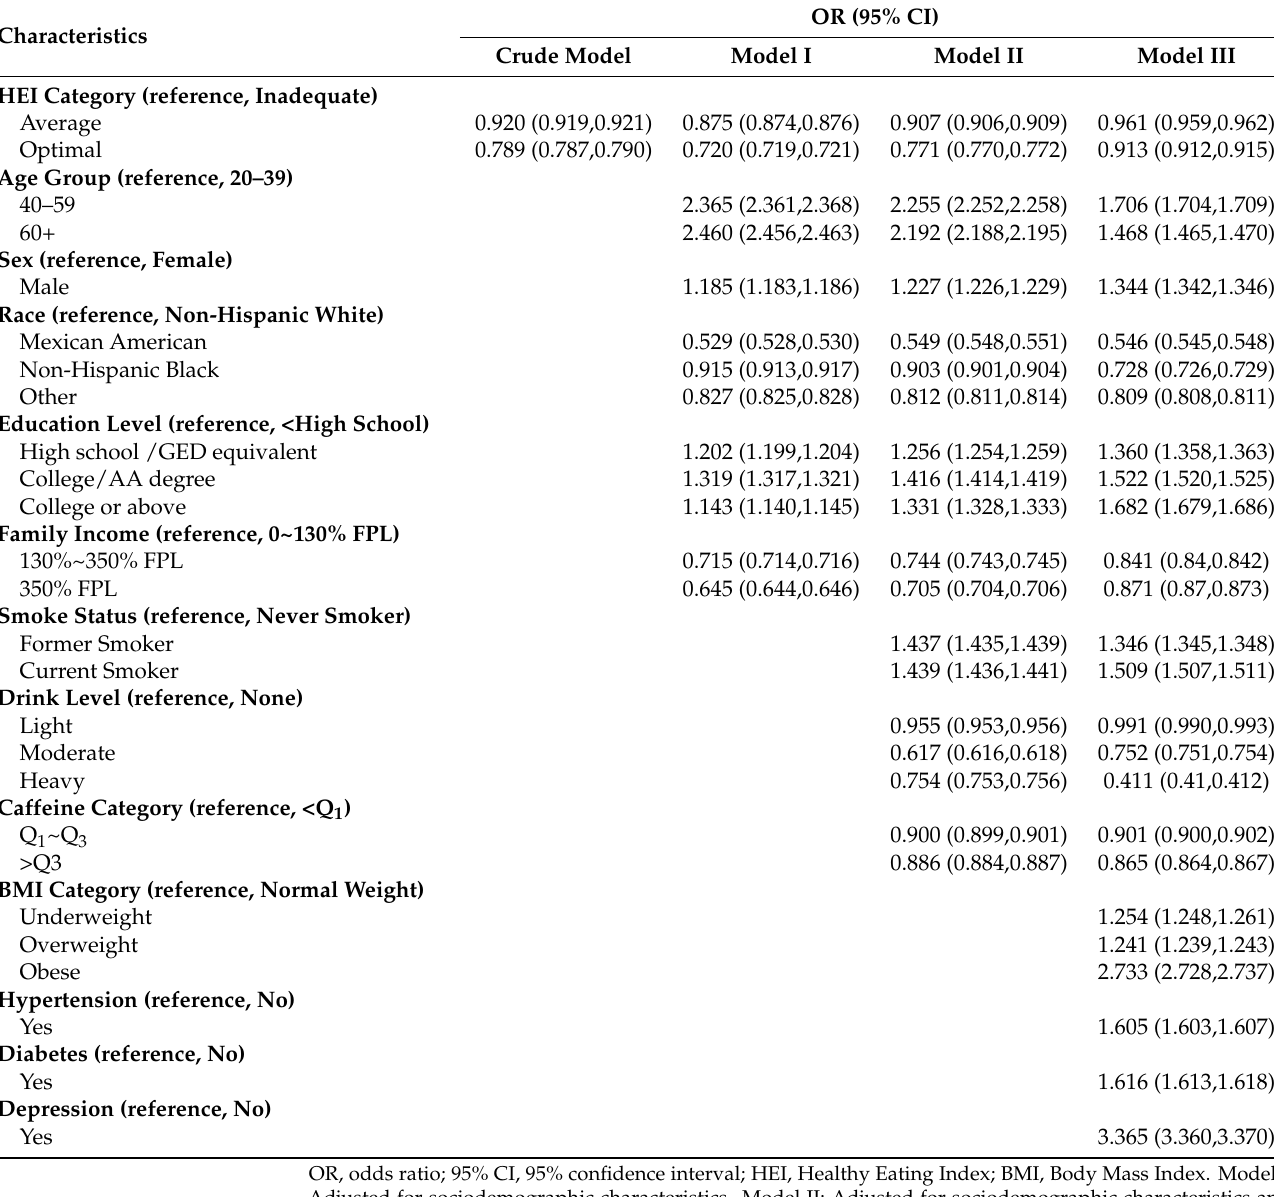
Table 3. Relationship between HEI and sleep disorder among US adults aged 20+ years.